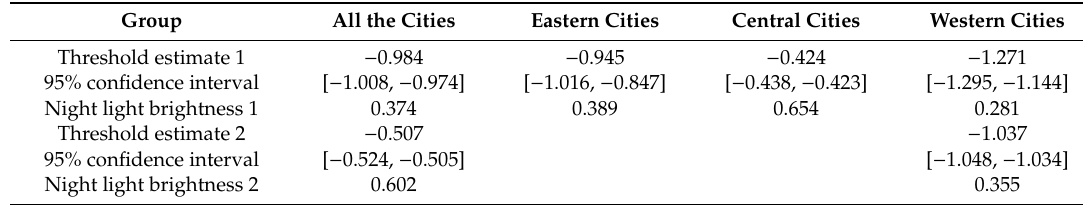
Table 7. Threshold and confidence interval